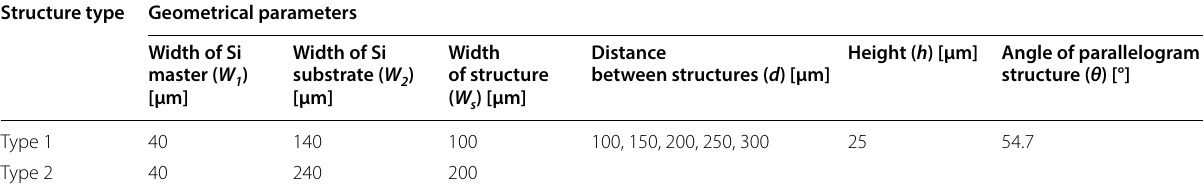
Table 1 Geometrical parameters of anisotropic surface with parallelogram structures Structure type Geometrical